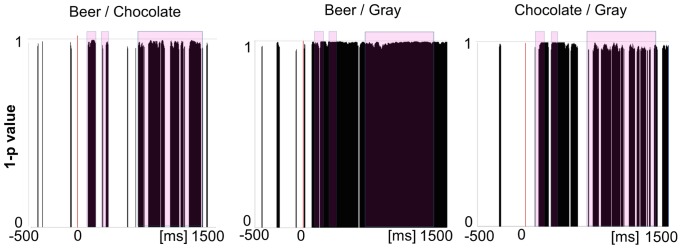
Time points of significant differences in EEG activity for the three main contrasts.Time points of significant differences in EEG activity for the three main contrasts (beer vs. chocolate, beer vs. grey and chocolate vs. grey) as indicated by the TANOVA analysis, depicting 1 minus p-value across time. Significant p values are plotted. The colored squares indicate the two time periods that contained the most pronounced differences between the beer image and the chocolate image, chosen as a focus for all subsequent analyses.